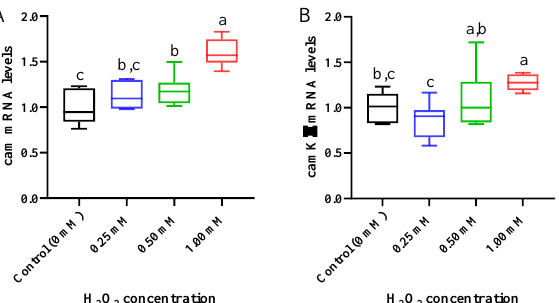
Figure 7. Expression of calcium signaling pathway-related genes in gills of Cyprinus carpio under H 2 O 2 exposure. ( A ) Calmodulin ( cam ); ( B ) calmodulin-dependent protein kinase II ( camk II). Data are expressed as mean ± SE (n = 9). The different letters above each bar indicate a statistical significance among different concentrations of H 2 O 2 exposure ( p < 0.05).